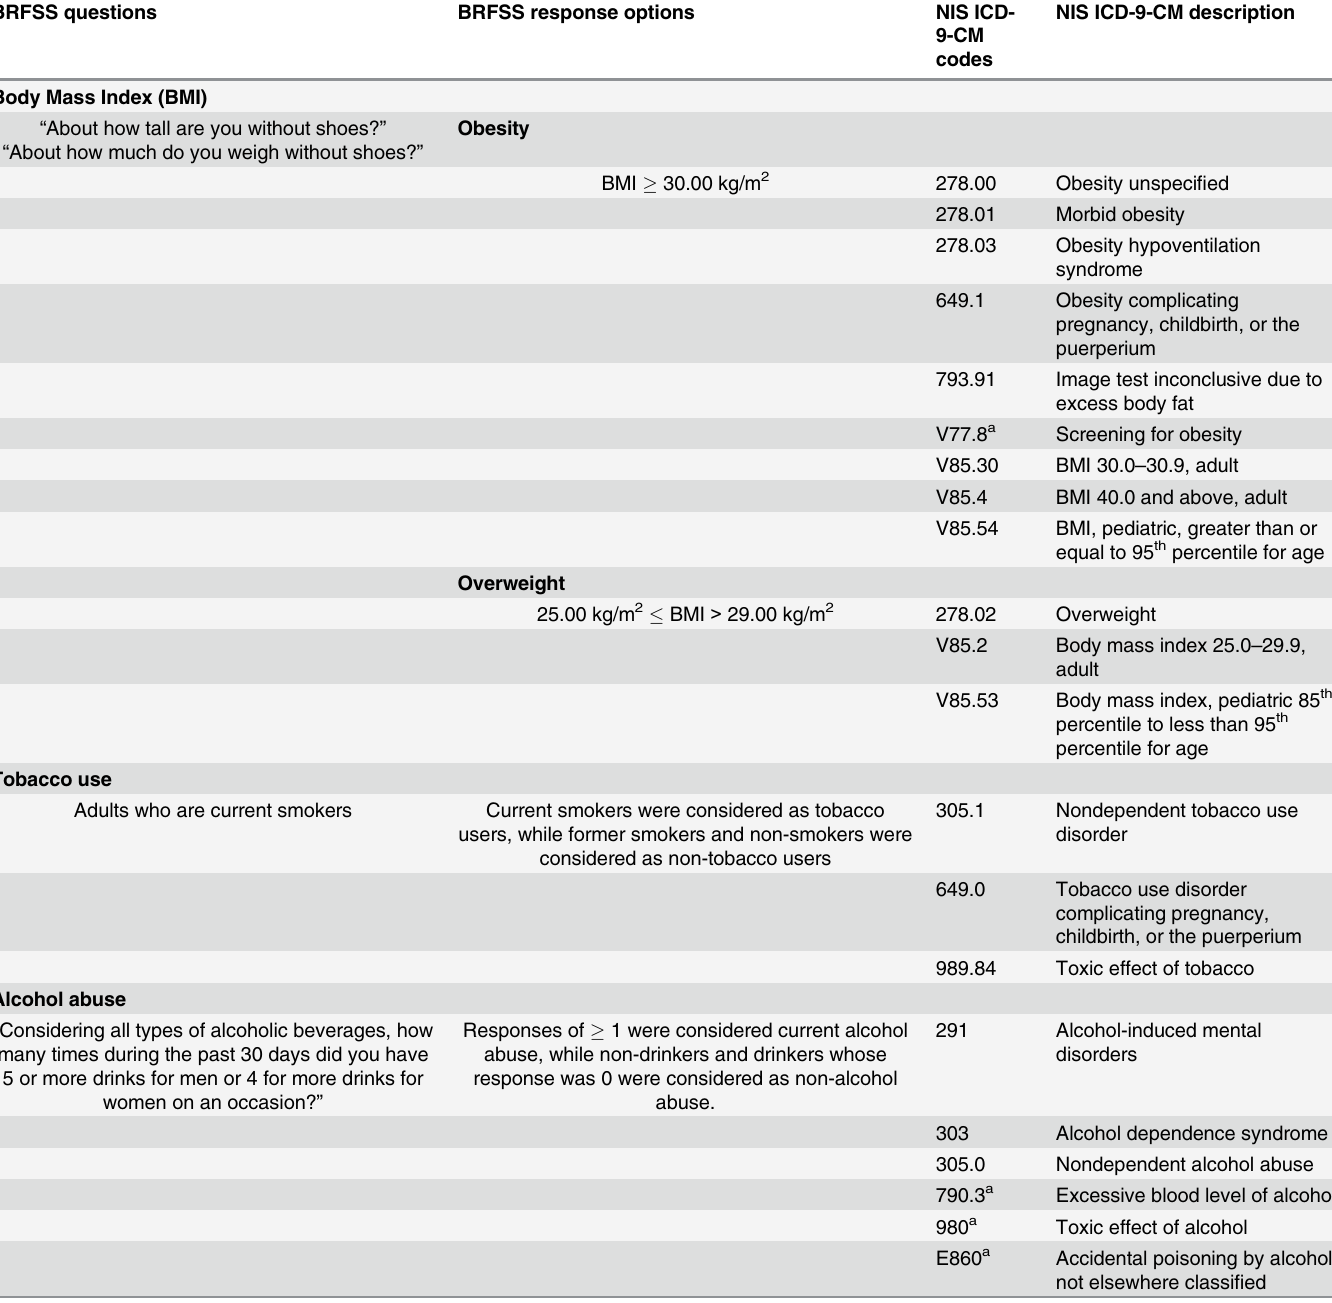
Table 1. BRFSS questions and NIS ICD-9-CM codes used to identify the conditions of